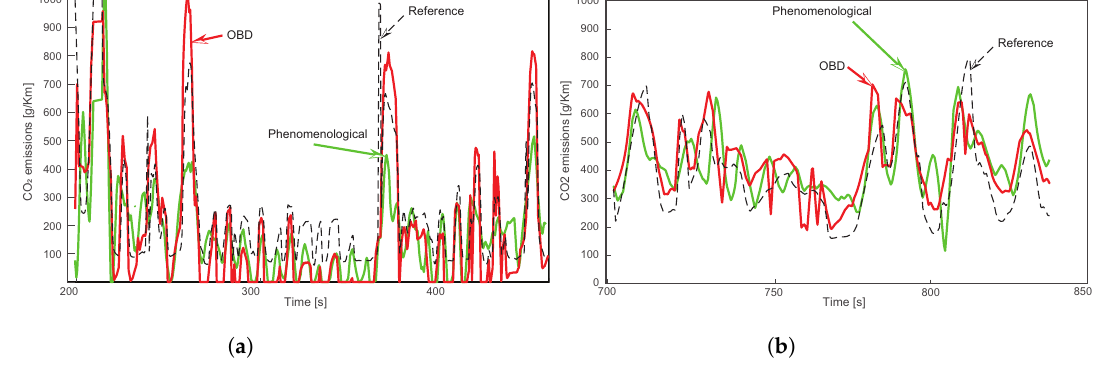
Figure 11. Comparison between CO 2 emission algorithms in experiments 13 ( a ) and 33 ( b